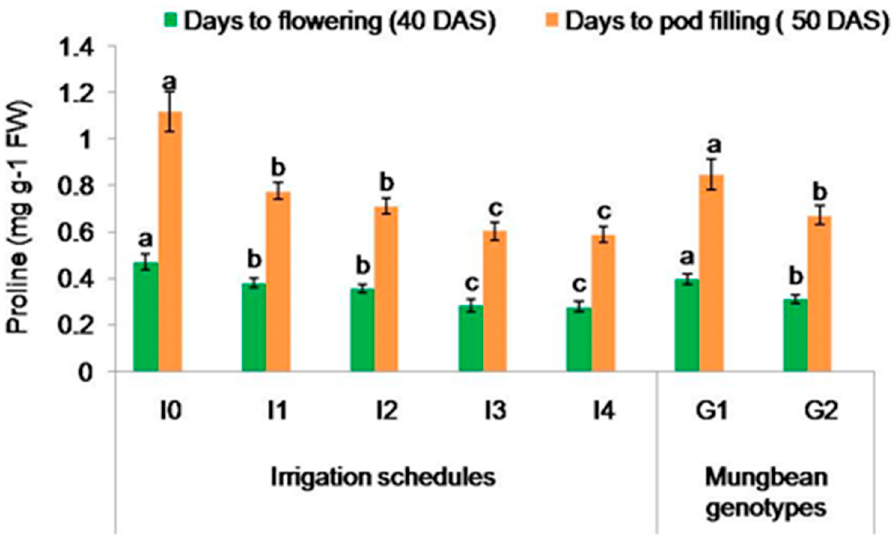
Figure 5. Proline content under different irrigation schedules and selected mungbean genotypes (Data followed by the same letter are not differed significantly by LSD test at p < 0.05).